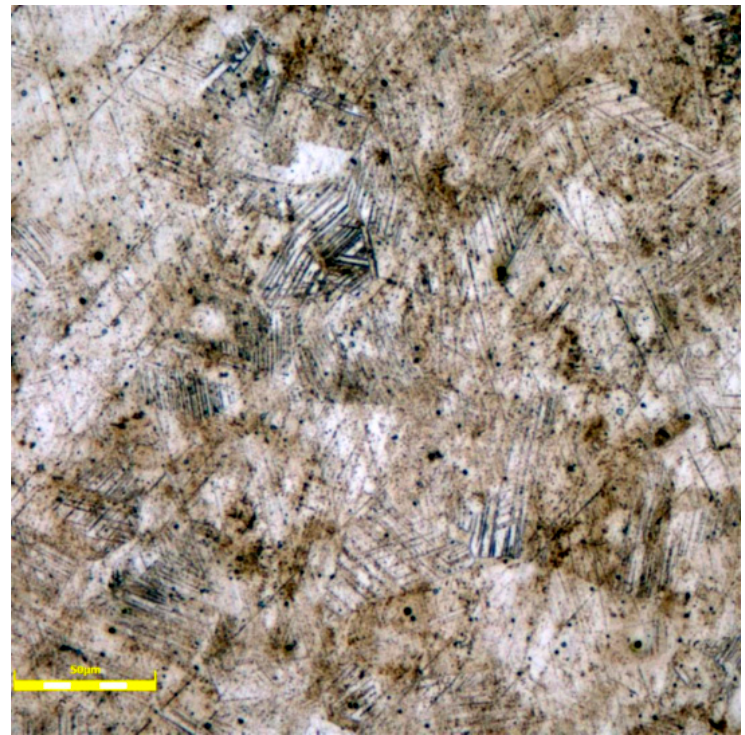
Figure 4. Microstructure of the 1.4301 stainless steel, transverse section in etched.